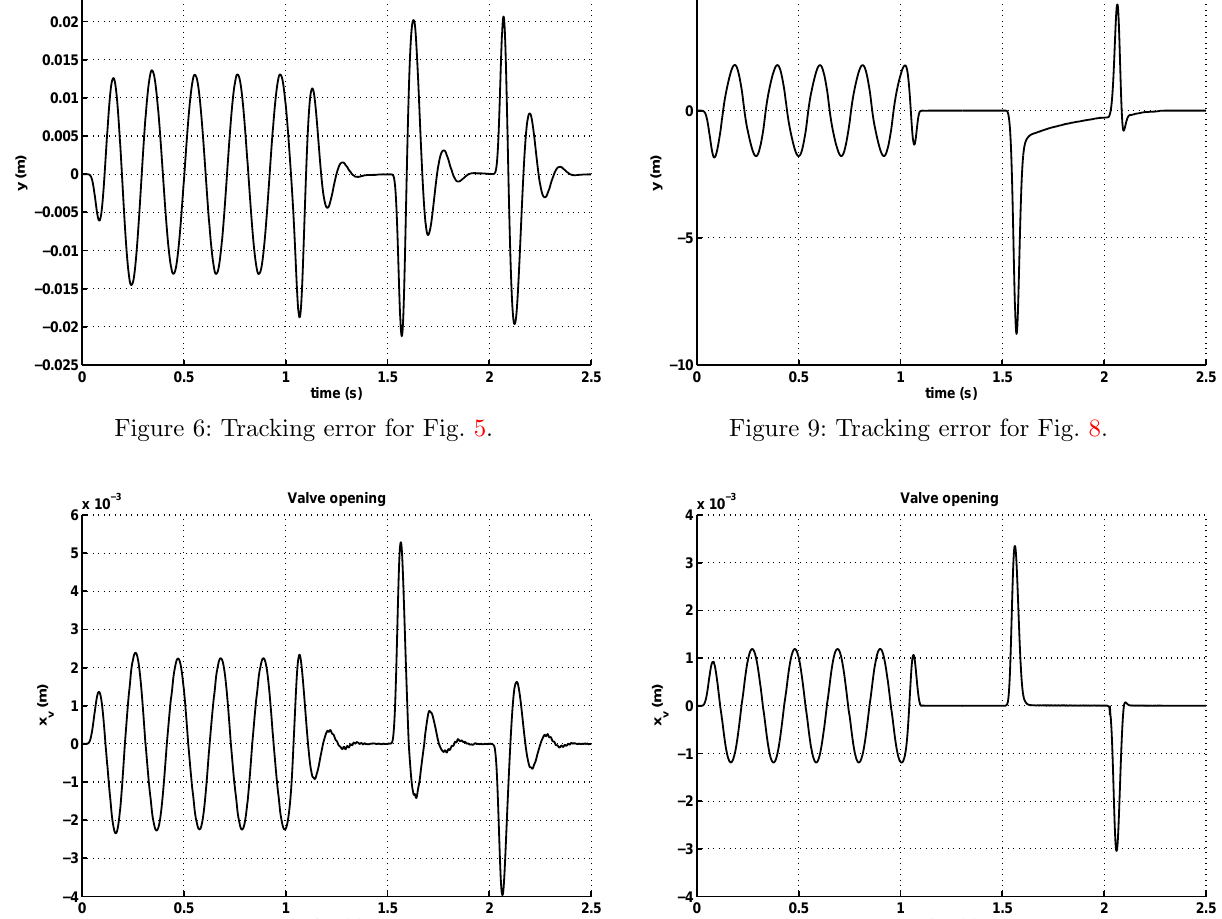
Figure 7: Input (valve opening) with the controller of section 3.